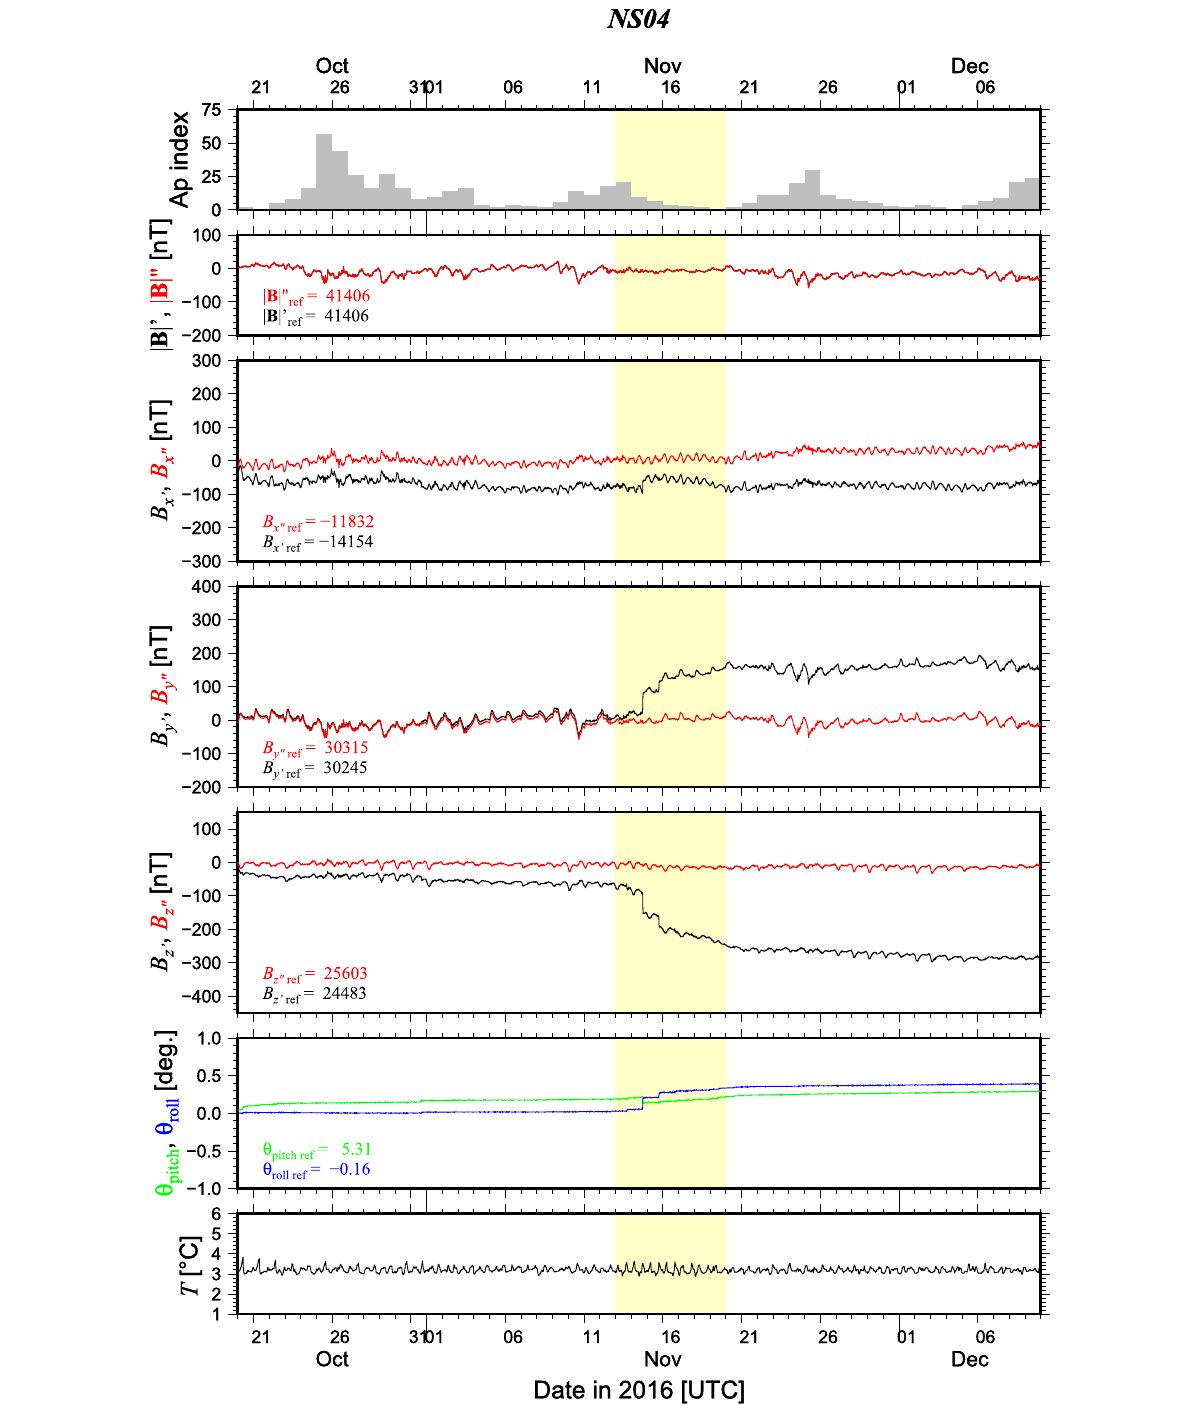
Fig. 2 Time series of Ap index (top) and the data observed by the OBEM deployed at NS04. For the magnetic field data in the second to fifth rows, the black and red lines are the data before and after tilt correction, respectively. These magnetic field data and two components of the tilt data in the sixth row were shifted by a reference value indicated in each panel. The reference values are those at 00:00:00 on October 20th, 2016 (UTC). The bottom row shows the temperature measured near the fluxgate sensor. Yellow shades indicate Period A (November 13–19th, 2016). See also Additional file 1: Figs. S1–S4 for details on the other